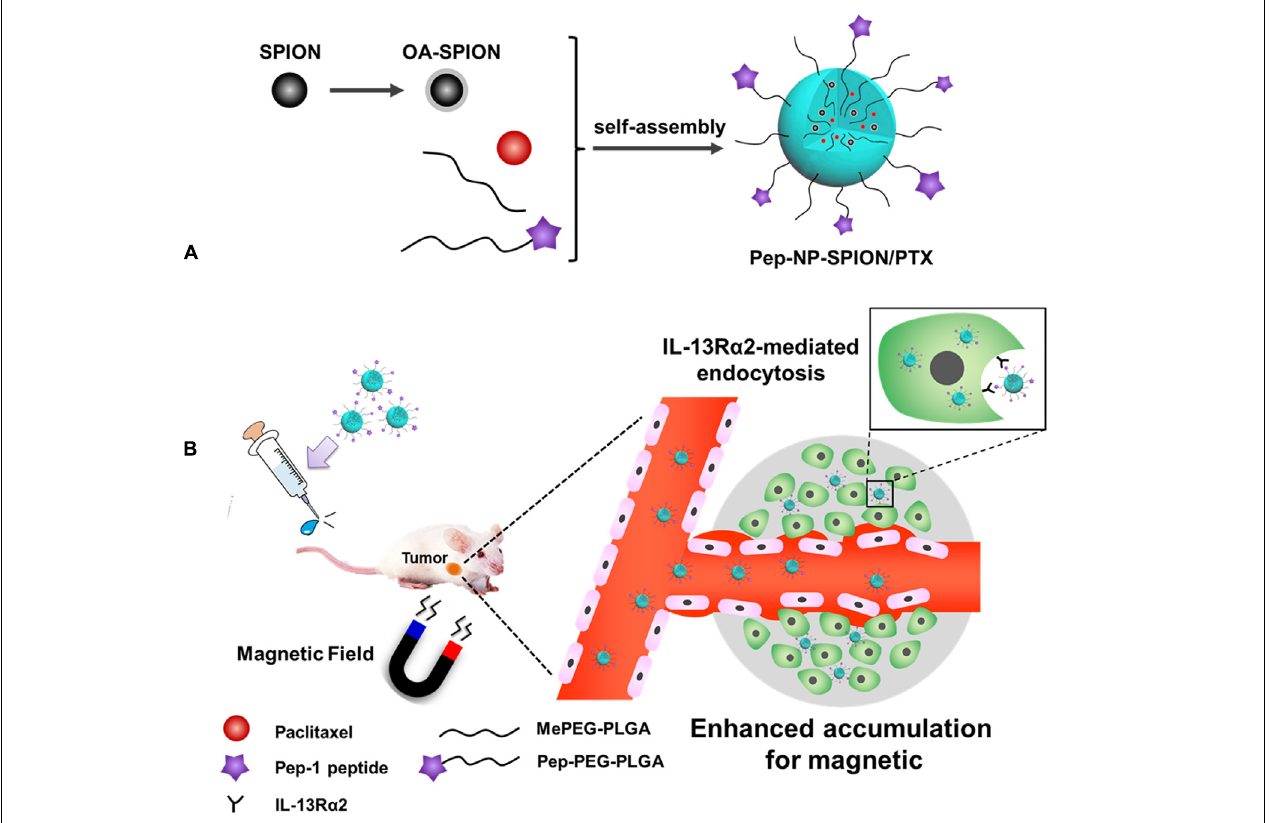
FIGURE 1 | Schematic design of Pep-NP-SPION/PTX. The main components and preparation of the Pep-NP-SPION/PTX (A) . After intravenous injection, Pep-NP-SPION/PTX targets to tumor tissue via external magnetic field and then is internalized into tumor cells through IL-13R α 2 mediated endocytosis (B)